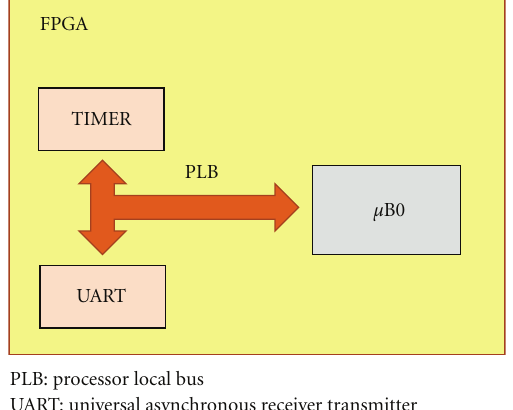
Figure 2: Uniprocessor system.